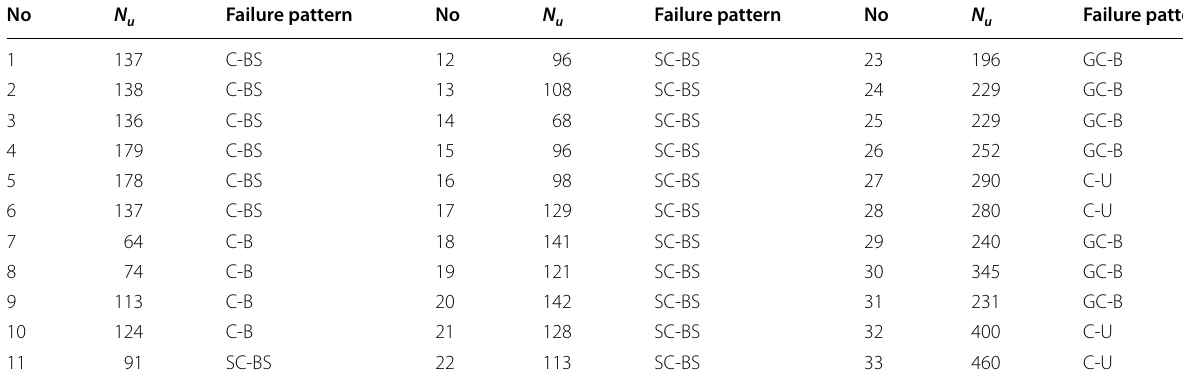
Table 2 Test results (Unit: